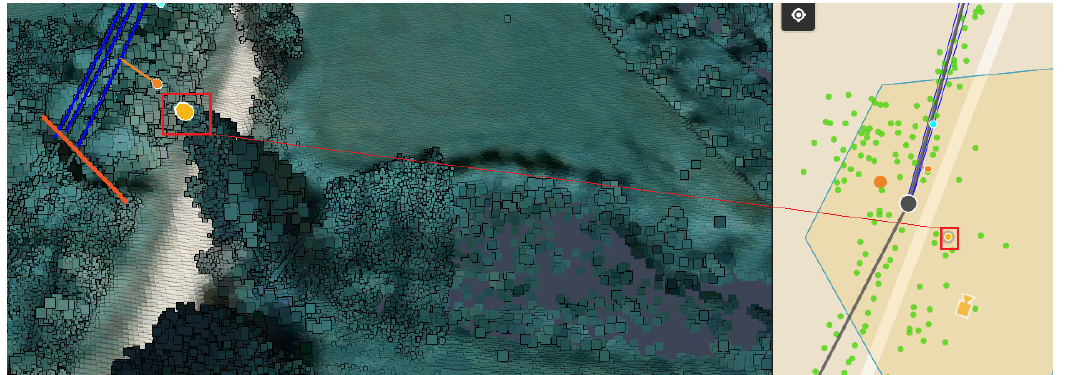
Figure 22. Examples of vegetation determination.